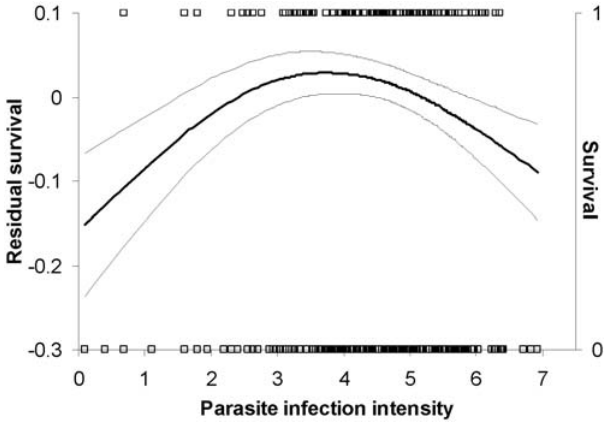
Figure 1. Survival of blue tits as a function of the infection intensity of Haemoproteusmajoris . The lines show residual survival (cubic spline, thick solid line 6 SE, thin solid lines; left y-axis) after controlling for effects of sex (logistic regression; x 2 =5.74, p =0.017), and year ( x 2 =18.44, p , 0.0001). Squares show individual data points (1=survived; right y-axis).